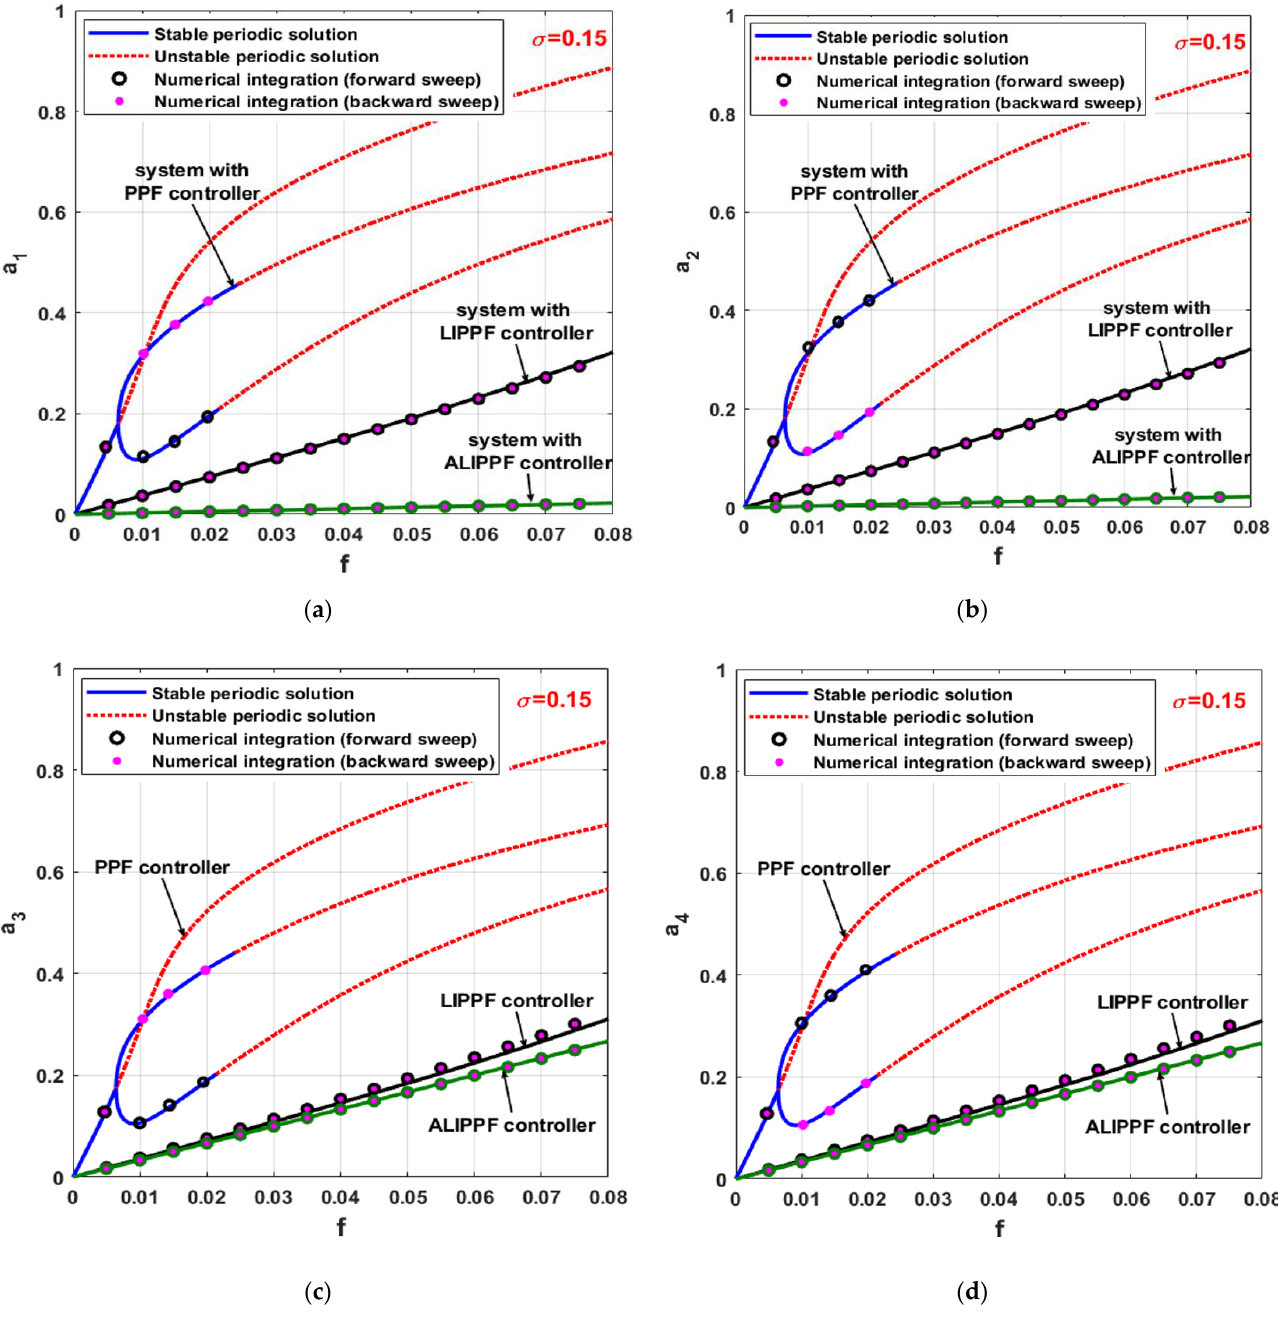
Figure 12. Vibration amplitudes of the rotor system, PPF-controller, LIPPF-controller, and ALIPPF-controller using the rotor eccentricity 𝑓 a bifurcation parameter when 𝜎 = 0.15 : ( a ) vibration amplitude in 𝑋 1 direction, ( b ) vibration amplitude in 𝑋 2 direction, and ( c , d ) vibration amplitudes of the PPF-controller, LIPPF-controller, and ALIPPF-controller.